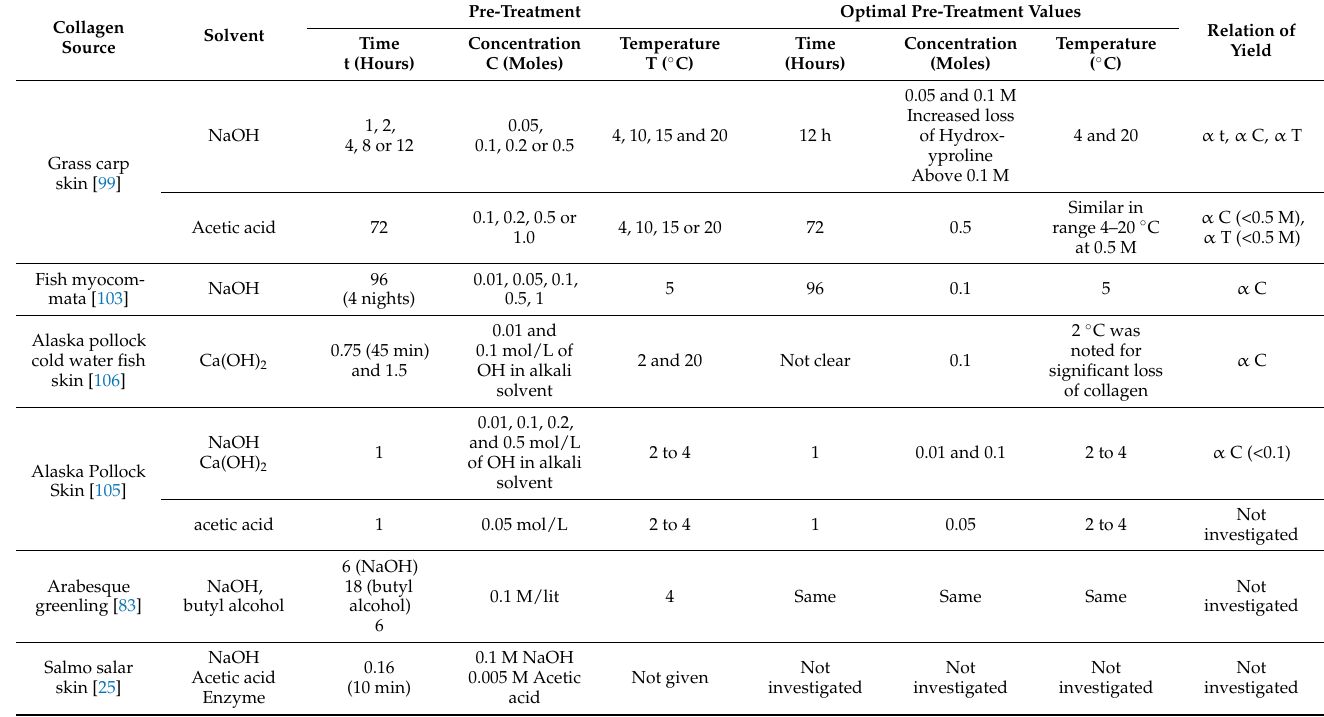
Table 5. Pre-treatment processes (alkaline, acidic, enzymatic) with common parameters. “ α ” means directly proportional. Pre-Treatment Optimal Pre-Treatment Values Collagen Solvent Source